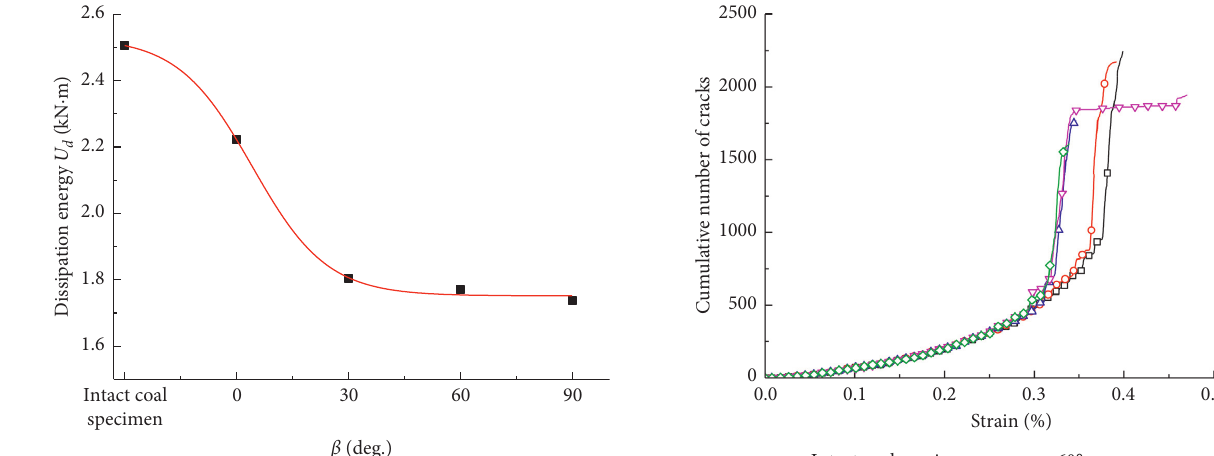
Figure 13: Relationship of the ESL and hole angle.